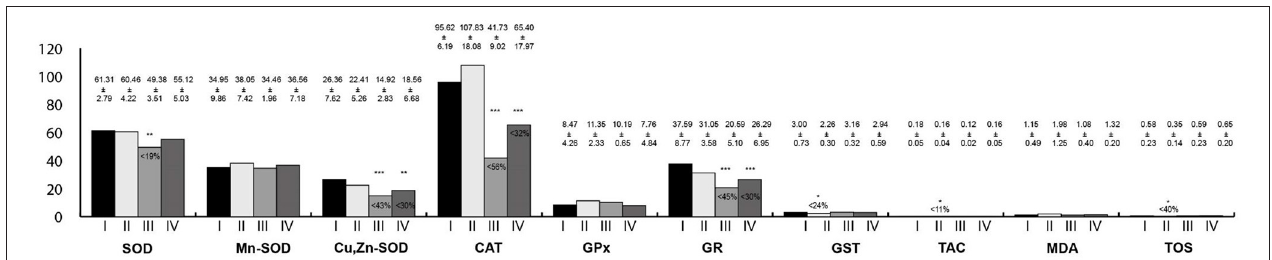
cavity (45). Bad dietary habits (46–48), chronic